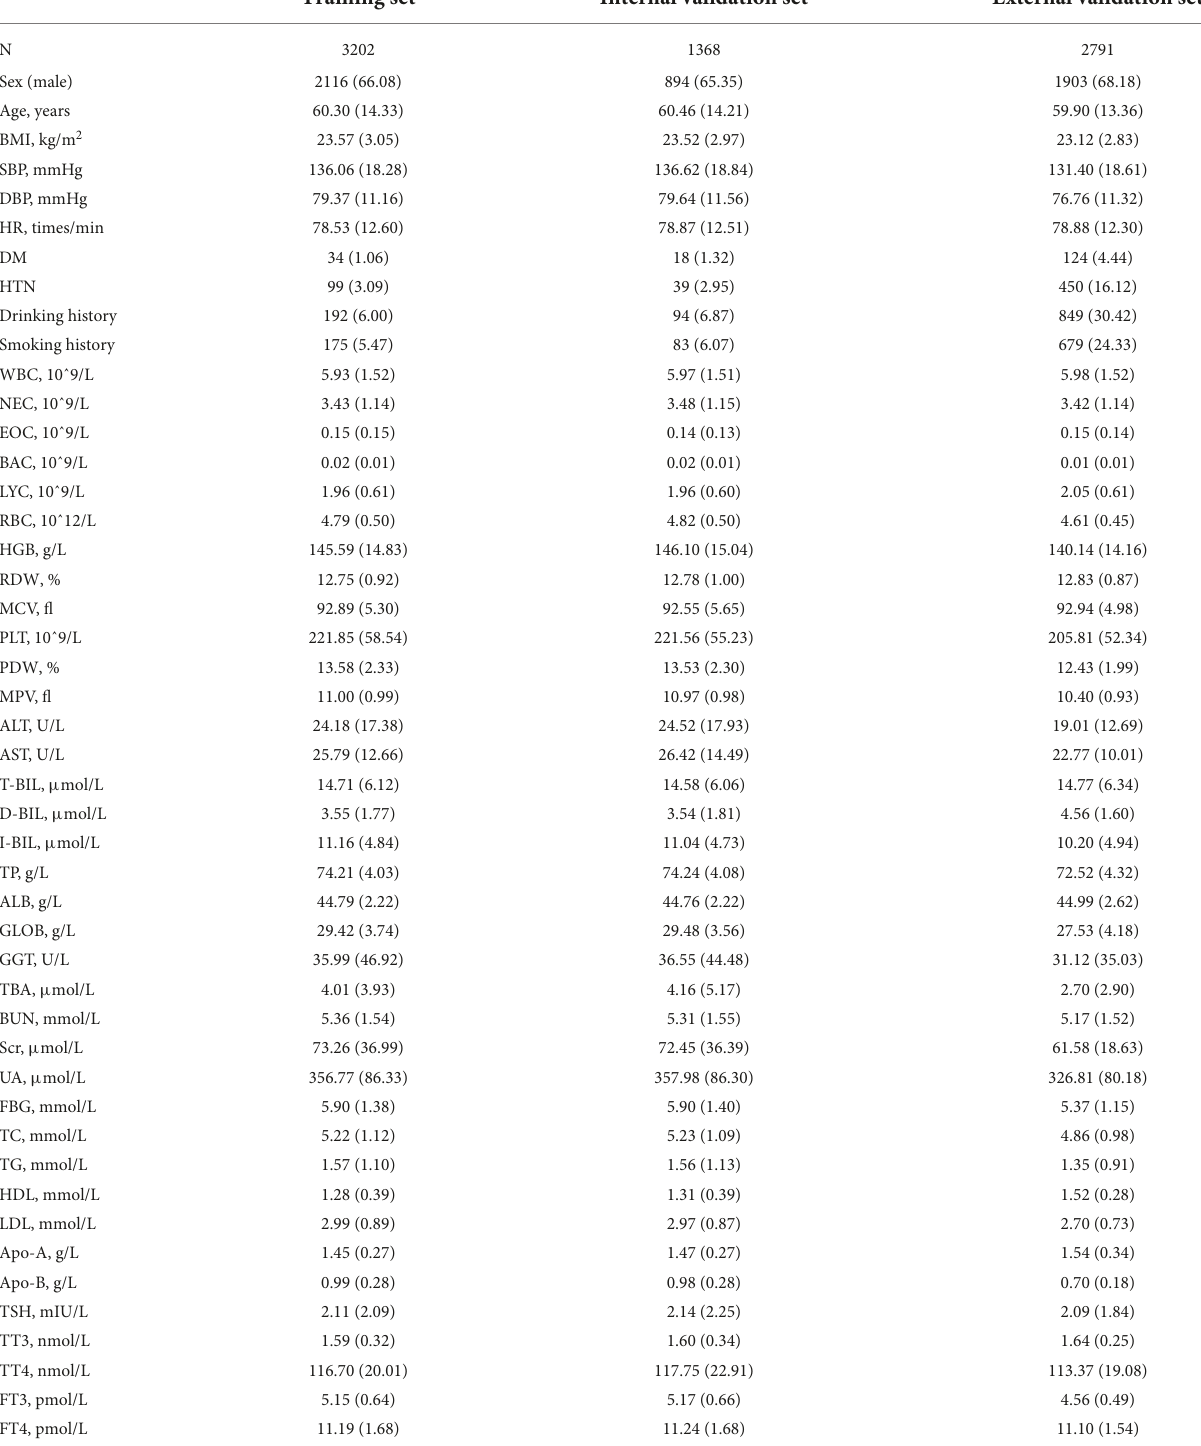
BMI, body mass index; SBP, systolic blood pressure; DBP, diastolic blood pressure; HR, heart rate; DM, diabetes mellitus; HTN, hypertension; WBC, white blood cell count; NET, neutrophil count; EOC, eosinophil count; BAC, basophil count; LYC, lymphocyte count; RBC, red blood cell count; HGB, hemoglobin; RDW, red blood cell distribution width; MCV, mean red blood cell volume; PLT, platelet count; PDW, platelet distribution width; MPV, mean platelet volume; ALT, alanine aminotransferase; AST, aspartate aminotransferase; T-BIL, totalbilirubin;D-BIL,directbilirubin;I-BIL,indirectbilirubin;TP,totalprotein;ALB,albumin;GLOB,globulin;GGT,gamma-glutamyltranspeptidase;TBA,totalbileacids;BUN,blood urea nitrogen; Scr, serum creatinine; UA, uric acid; FBG, fasting blood glucose; TC, total cholesterol; TG, triglycerides; HDL, high-density lipoprotein; LDL, low-density lipoprotein; Apo-A,apolipoprotein-A;Apo-B,apolipoprotein-B;TSH,thyroidstimulatinghormone;TT3,totaltriiodothyronine;TT4,totaltetraiodothyronine;FT3,freetriiodothyronine;FT4,free